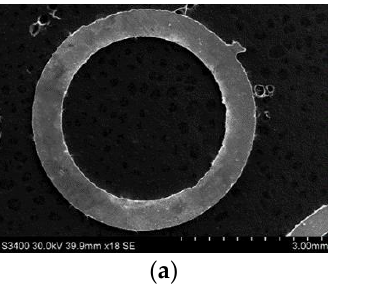
Figure 15. The feed trajectories of the outer circle and inner circle.